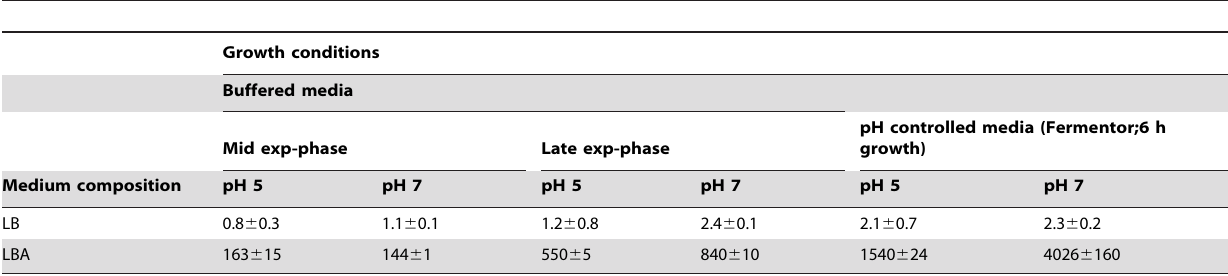
Table 4. b -galactosidase activity (MU) of JH2-2 P aguB - lacZ grown under different conditions, pH values and in the presence or absence of agmatine.